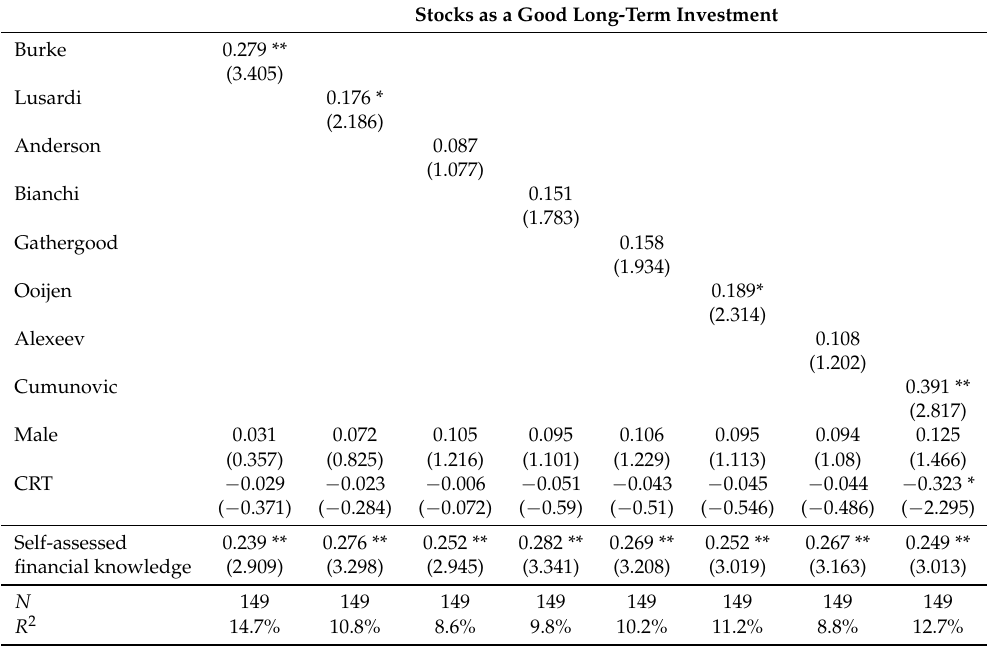
Table 13. External validity of the original financial literacy measures regarding the view of stocks as a good long-term